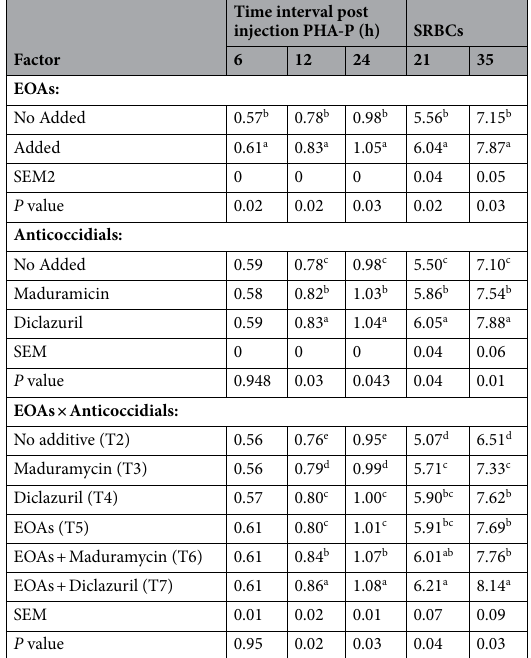
Table 5. Effect of dietary EOAs and anticoccidials on immune responses against PHA-P 1 and SRBCs 2 in infected broilers. 1 Phytohemagglutinin-P. 2 Sheep red blood cells. a–b In each column, means with no same (a, b) superscript differ significantly in p < 0.05 value. 2 Pooled standard error of